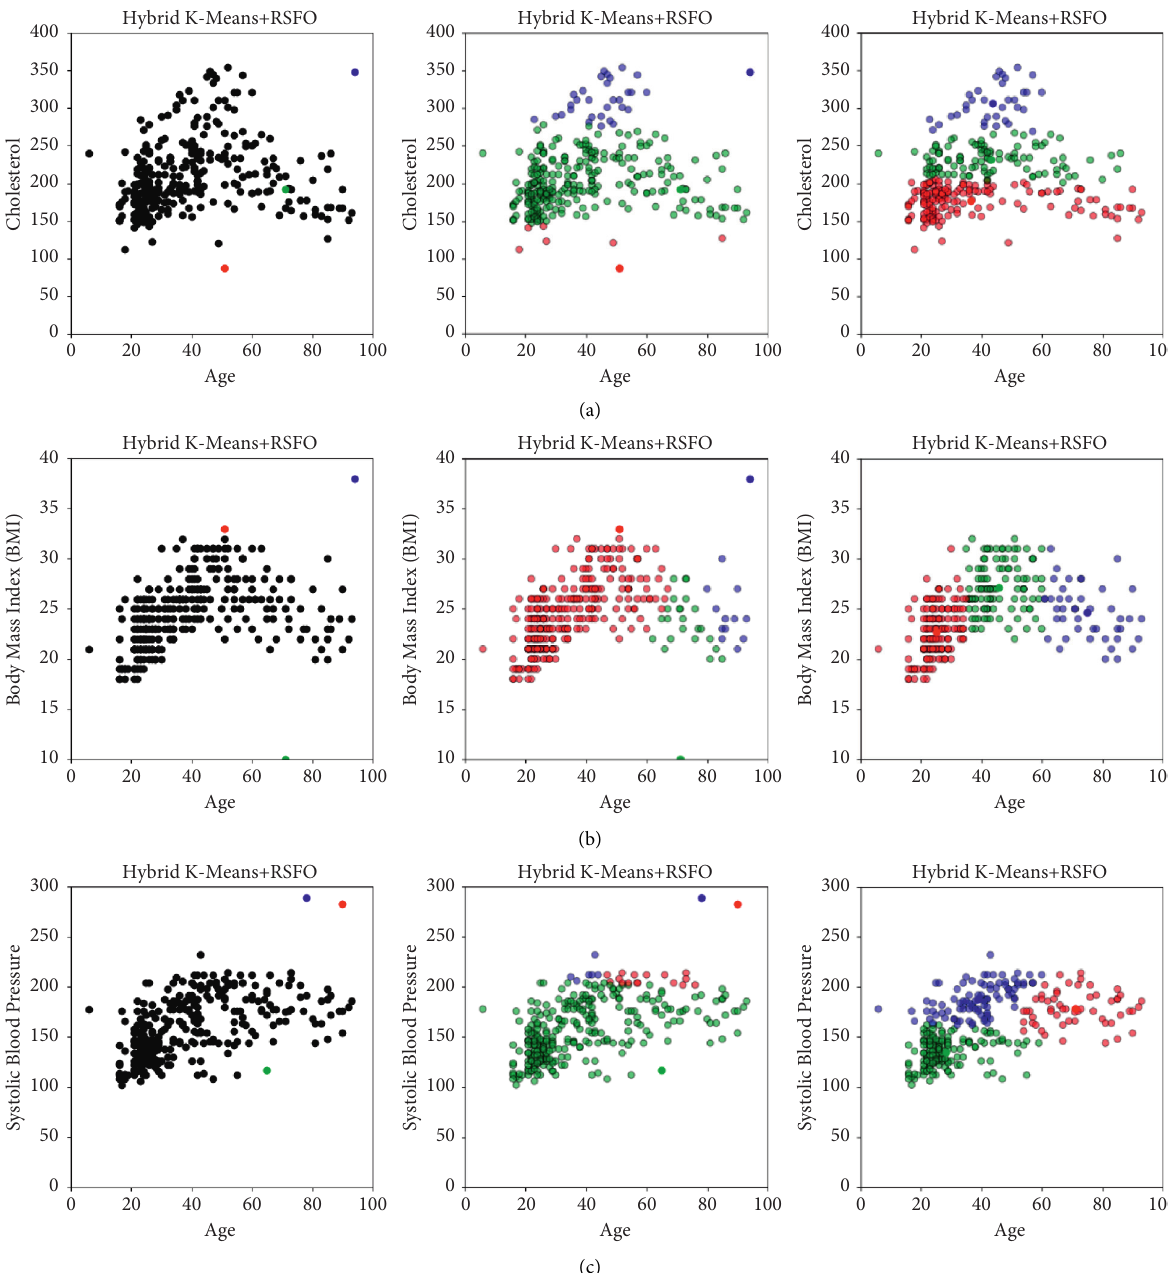
Figure 2: (a) Two-dimensional clustering simulation for age vs cholesterol by using hybrid K-means-based RSFO algorithm. (b) The 2-D clustering simulation of age vs body mass index by using K-means-based RSFO algorithm. (c) The 2-D clustering simulation for age vs random blood pressure using hybrid K-means-based RSFO